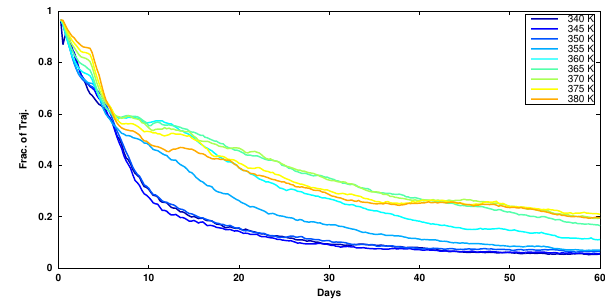
Figure 16. Fraction of diabatic trajectories that remain in the anti- cyclone region as a function of time after initialization for different initial potential temperature levels (see legend).